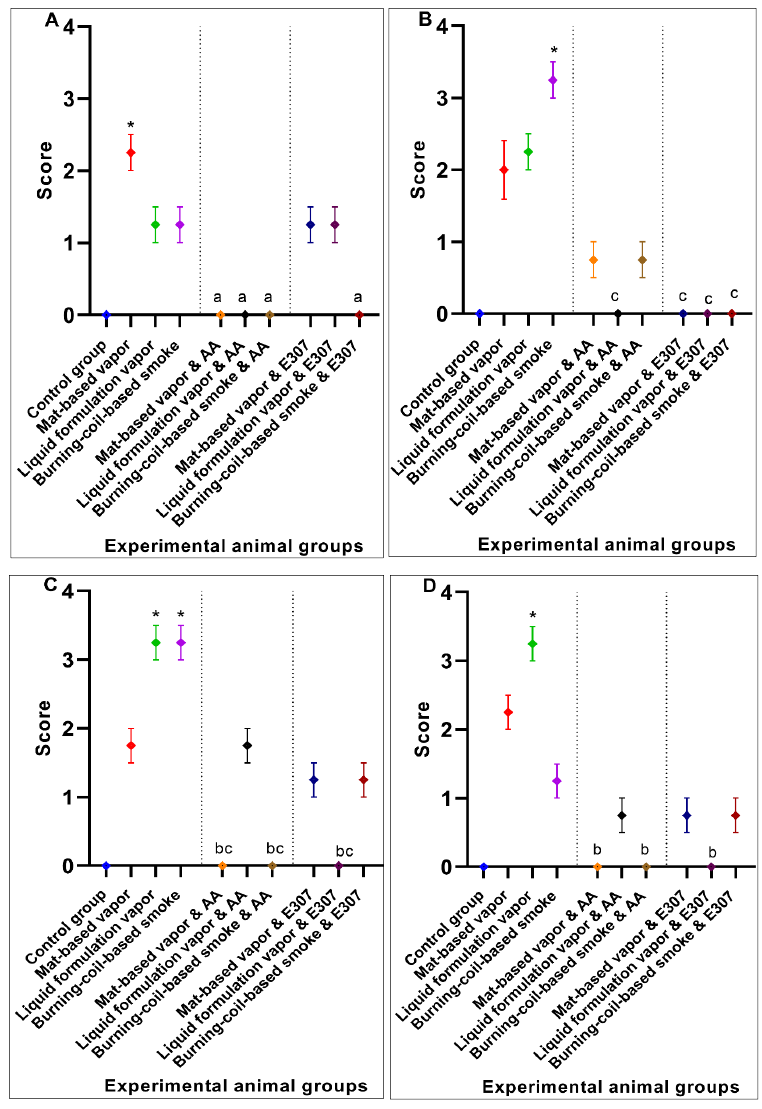
Figure 3. Effects of ascorbic acid (AA) and α -tocopherol (E307) on pyrethroid-induced toxicity in the livers showing inflammation ( A ), hyperemia ( B ), necrosis ( C ), and occlusion by hyaline ( D ) in the animals’ tissue. Values are expressed as mean ± S.E. The Kruskal–Wallis non-parametric test was used for group differences and Dunnett’s corrections of the significance level for multiple comparisons were performed. The significance levels ( p -values) using Dunnett’s corrections for all the variables were as follows: graph ( A ): *— p = 0.02 vs. the control group, while the letter a denotes p = 0.02 compared to the animals exposed to mat-based vapor; graph ( B ): *— p = 0.02 vs. the control group, while the letter c denotes p = 0.02 compared to the animals exposed to burning-coil-based smoke; graph ( C ): *— p = 0.01 vs. the control group, while the letters b and c denote p = 0.01 compared to the animals exposed to liquid formulation vapor and burning-coil-based smoke, respectively; graph ( D ): *— p = 0.01 vs. the control group, while the letter b denotes p = 0.01 compared to the animals exposed to liquid formulation vapor.